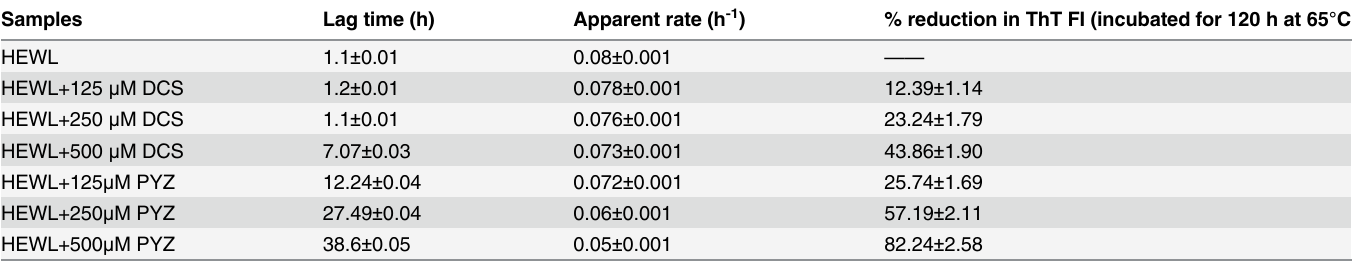
Table 1. Kinetic parameters obtained on sigmoidal fitting of time kinetics curves and percent reduction in ThT fluorescence intensity of heat induced aggregation of HEWL in absence and presence of varying concentration of DCS and PYZ.